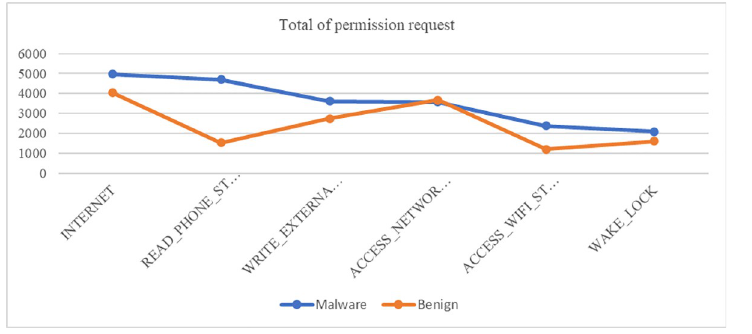
Fig 7. Comparison of total permission requests by malware and benign